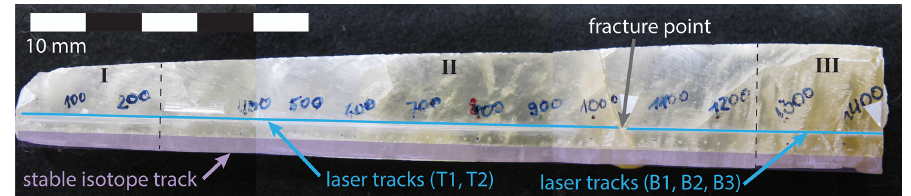
Figure 2. Polished slab of SPA 127 (top is left). The locations of the stable isotope track and of the LA-AMS tracks are marked in purple and blue, respectively. The total length of the slab is 14.6cm. Roman numerals and dashed black lines mark the three sections discussed